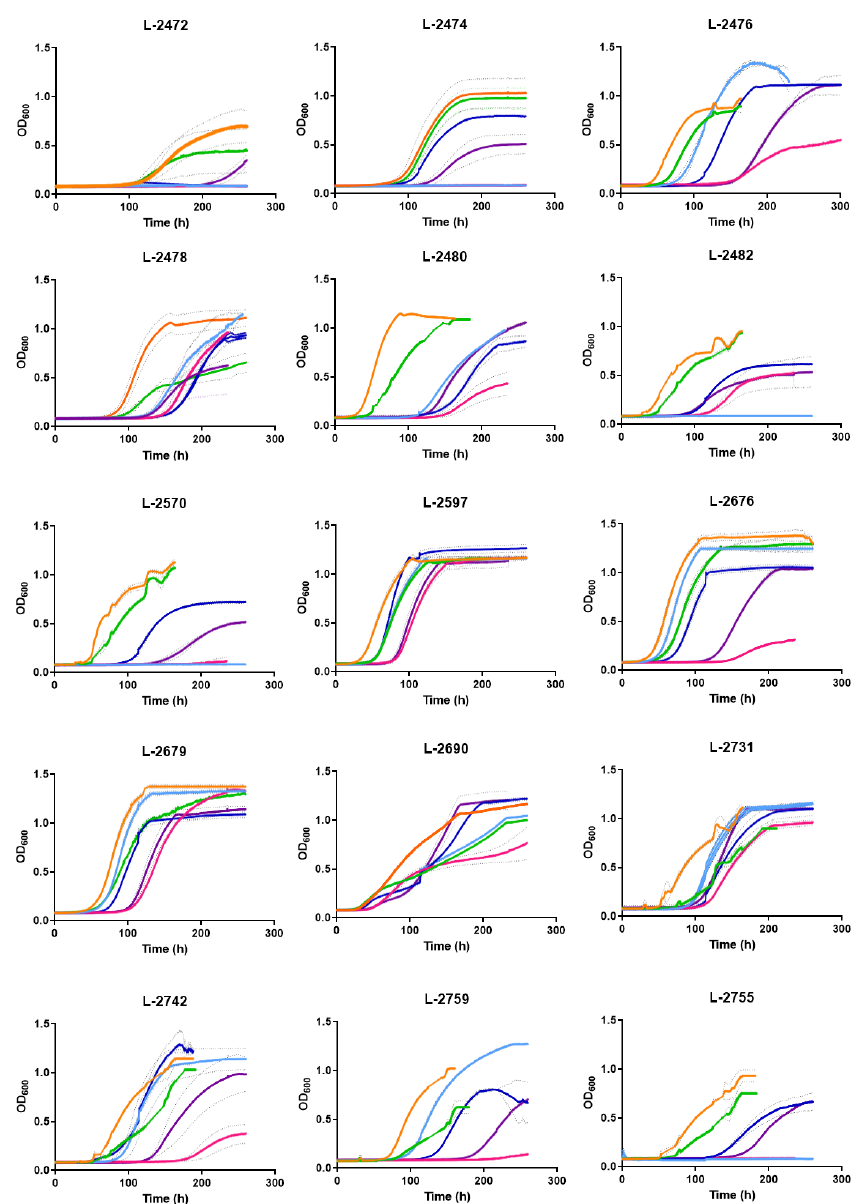
Figure 3. Growth curves of wine strains of Brettanomyces bruxellensis from Chile in synthetic (YNB) medium (orange curves),synthetic media supplemented with p -coumaric acid (100 mg L − 1 ) (green curves), SO 2 (0.3 mg L − 1 ) (light blue curves), SO 2 (0.6 mg L − 1 ) (Pink), SO 2 (0.3 mg L − 1 ) and p -coumaric acid (100 mg L − 1 ) (blue curves) and SO 2 (0.6 mg L − 1 ) and p -coumaric acid (100 mg L − 1 ) (purple curves).